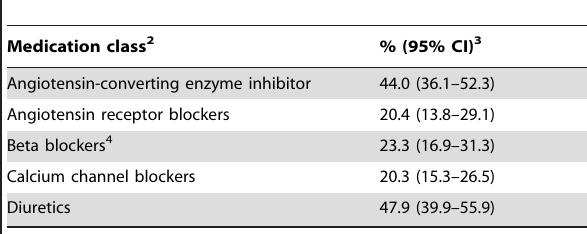
Table 3. Anti-hypertensive use 1 of reproductive aged women, 20–44, United States, National Health and Nutrition Examination Survey,